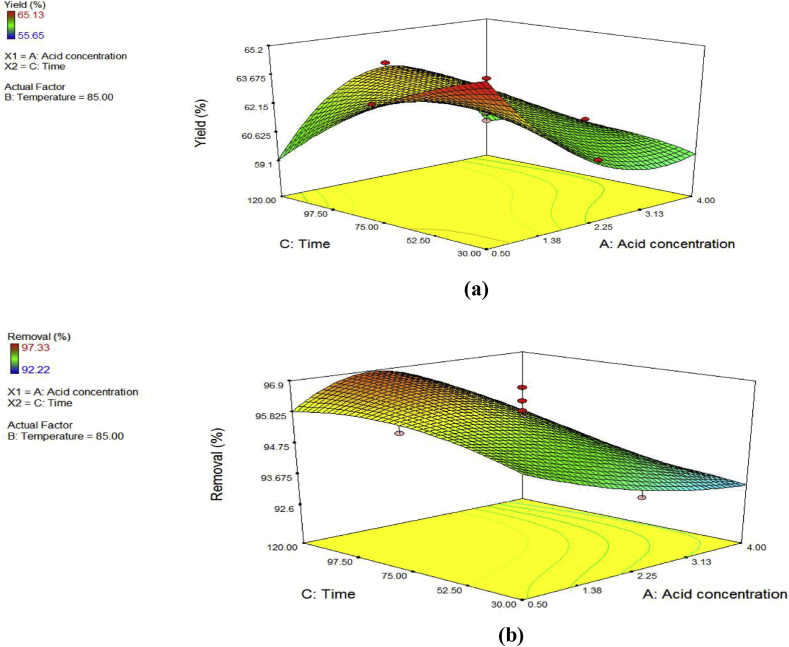
Acid concentration and time effect on percentage (a) yield and (b) Pb2+ removal on HCl activated Aloji clay (constant activation temperature 85 °C).